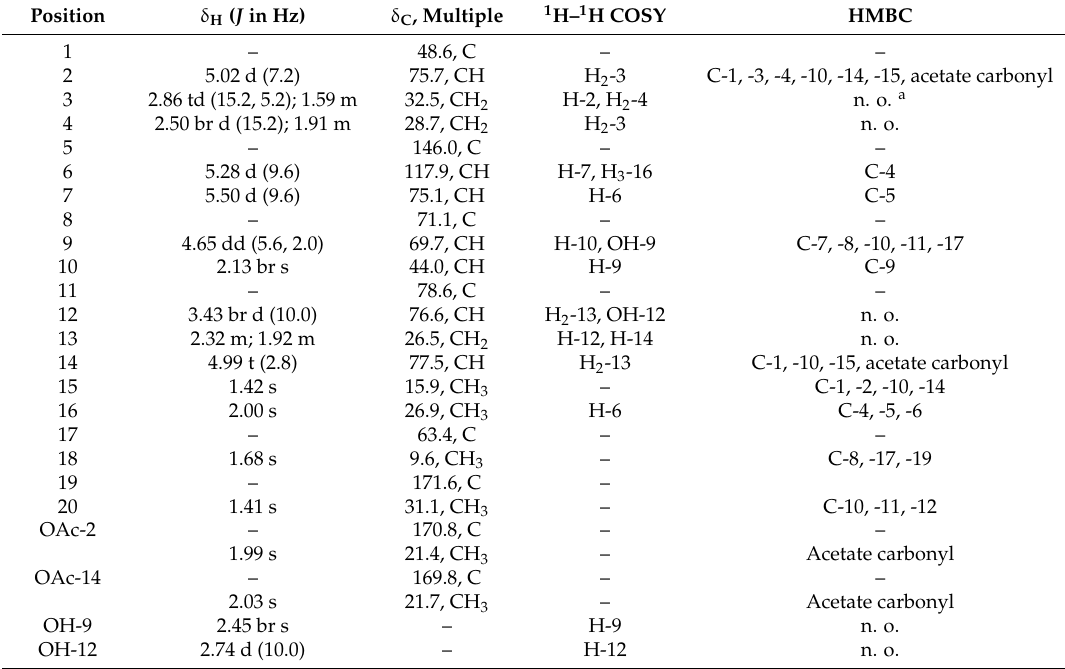
Table 5. 1 H (400 MHz, CDCl 3 ) and 13 C (100 MHz, CDCl 3 ) NMR data and 1 H– 1 H COSY and HMBC correlations for briarane 5